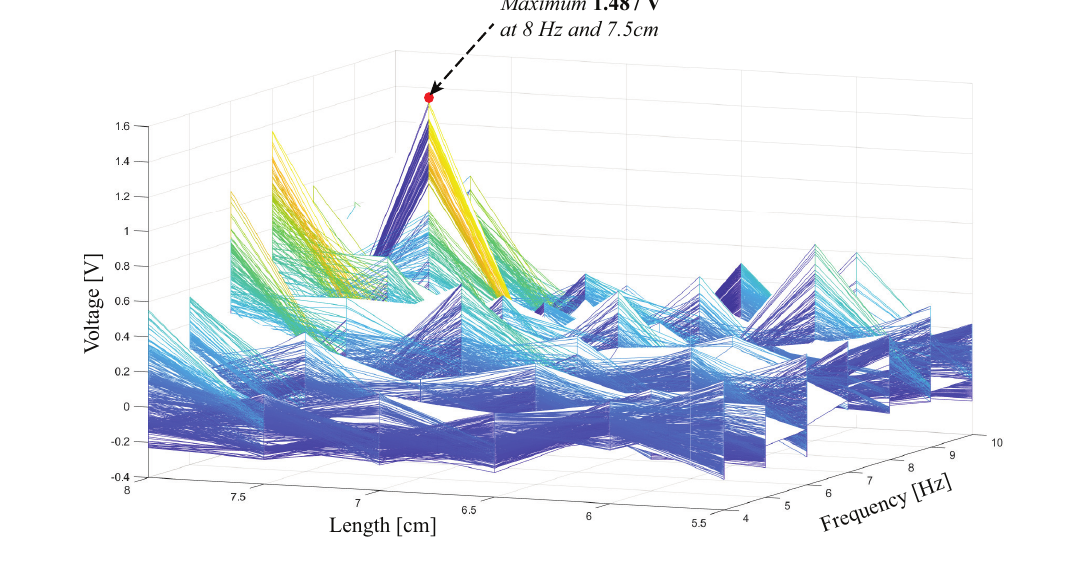
Figure 26. Energy harvesting for Replica 3. The maximum generated voltage was 1.487